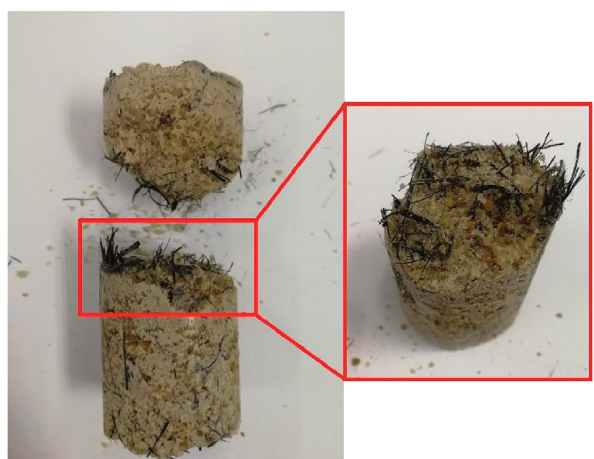
Figure 11: Three-dimensional ribbed structure of the sample with carbon